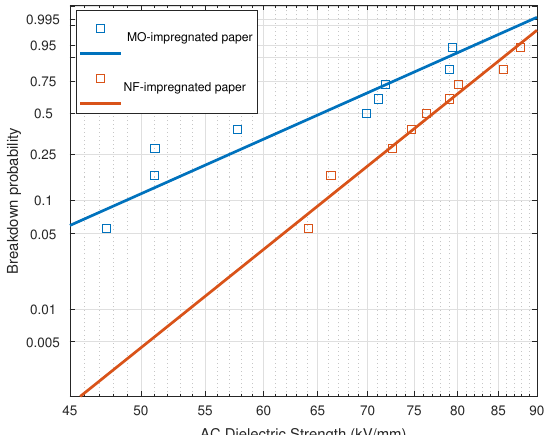
Figure 7. Weibull distribution of the AC dielectric strength measures on NF-impregnated paper and MO-impregnated paper.